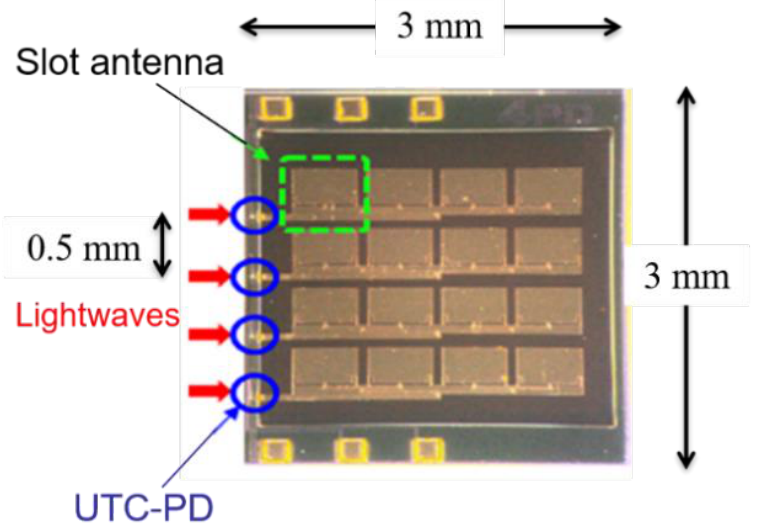
Figure 3. Arrayed UTC-PDs with integrated terahertz antennas.